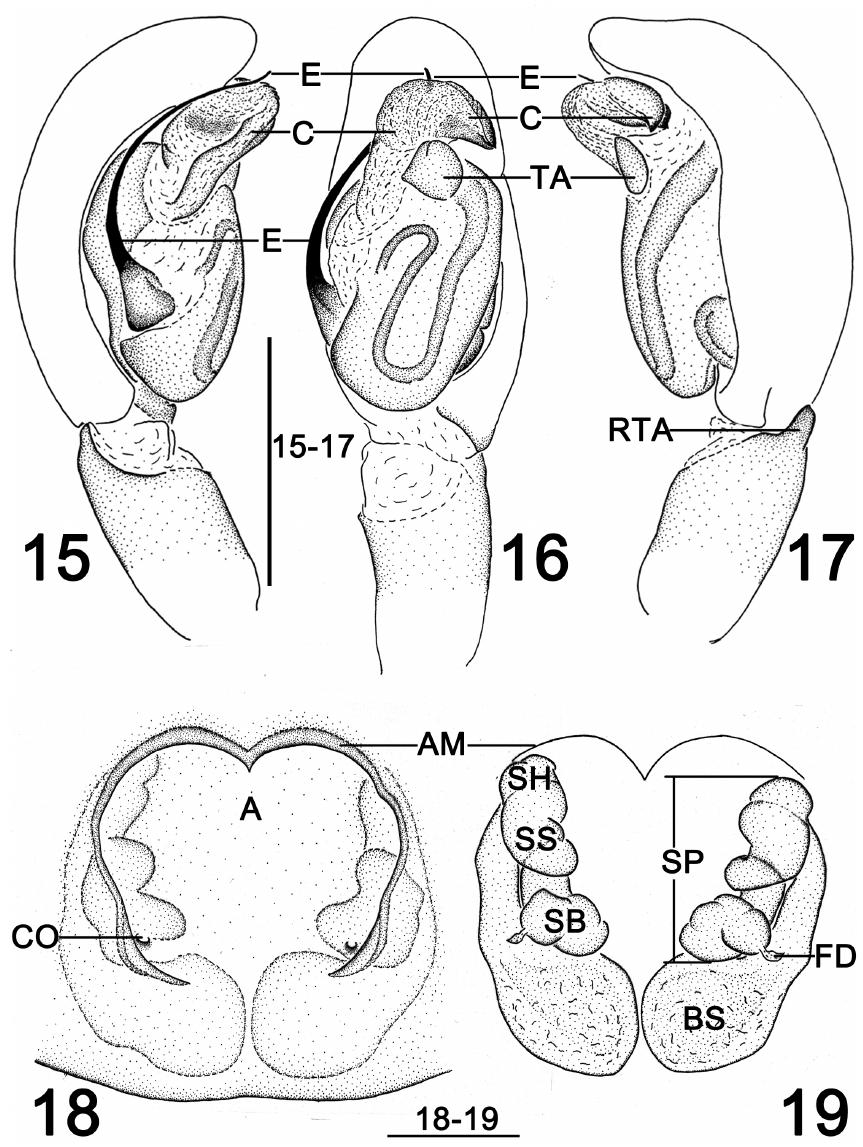
Figures 15–19. Clubiona grucollaris sp. n., male holotype and female paratype. 15 left palp, prolateral view 16 same, venteral view 17 same, retrolateral view 18 epigyne, ventral view 19 vulva, dorsal view. Scale bars 0.5 mm ( 15–17 ); 0.2 mm ( 18–19